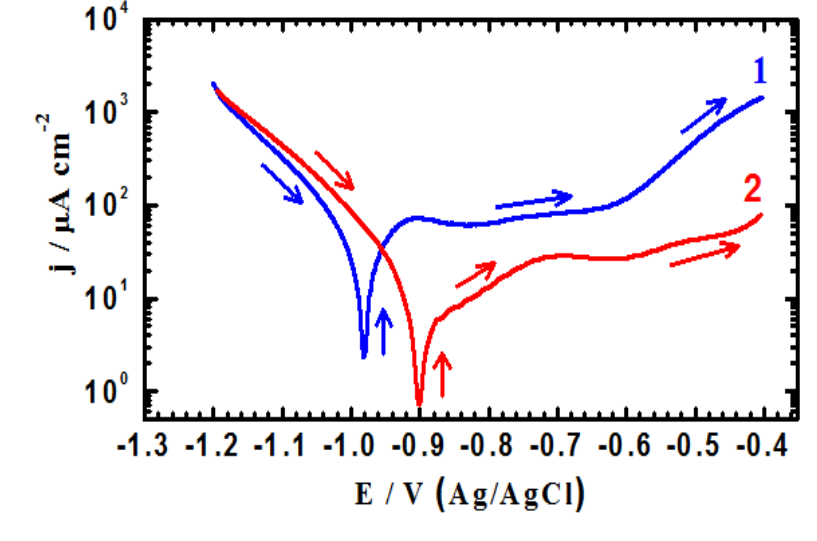
Figure 1. Potentiodynamic polarization curves for (1) pure iron and (2) API X-65 steel after their immersions for 40 min in 4.0 wt % NaCl